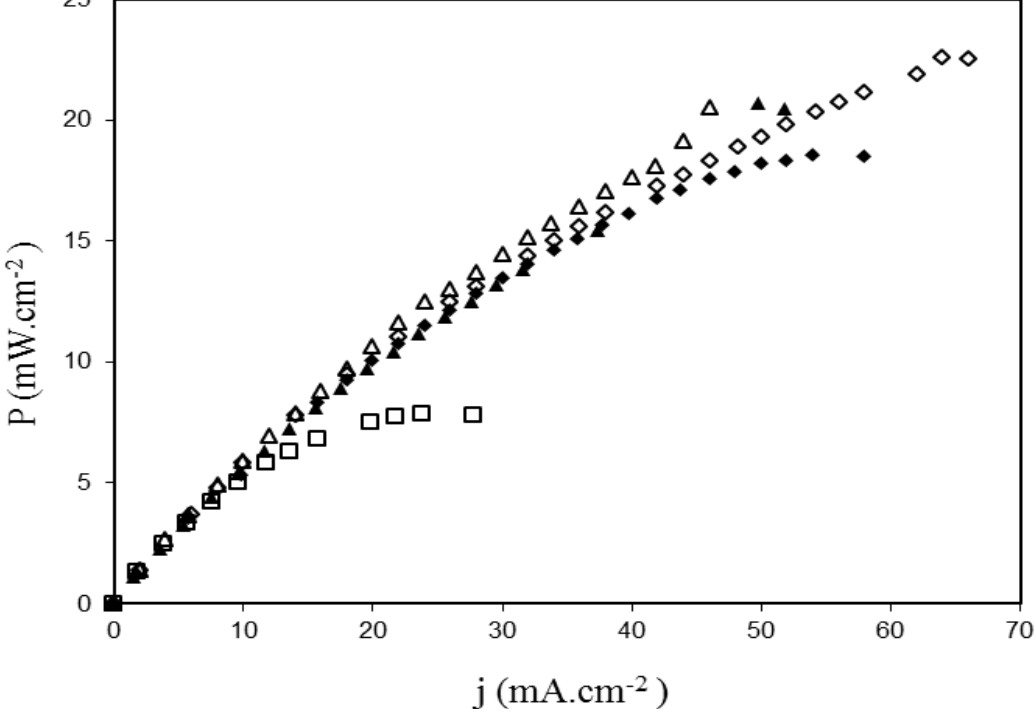
Figure 11. Power density curves recorded in SAFCs at 80°C fitted with MEA realized with ADP-Morgane ® membranes. Membrane □ is pristine ADP-Morgane ® . Membranes ♦ and ▲ are one-side treated membranes at 2 and 80 W (10 min), respectively (the treated side is positioned close to the anode during fuel cell tests). Membranes ◊ and Δ are both-sides treated membranes at 2 and 80 W (10 min), respectively.